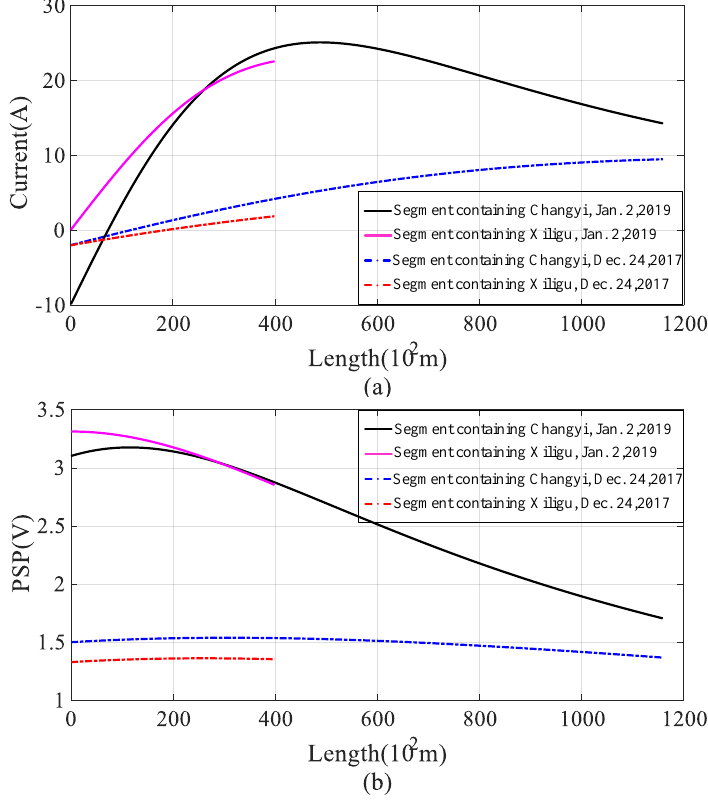
Figure 7. Calculation results of the stray current ( a ) and PSP ( b ) in the two pipeline segments during the commissioning of the two UHVDC projects.